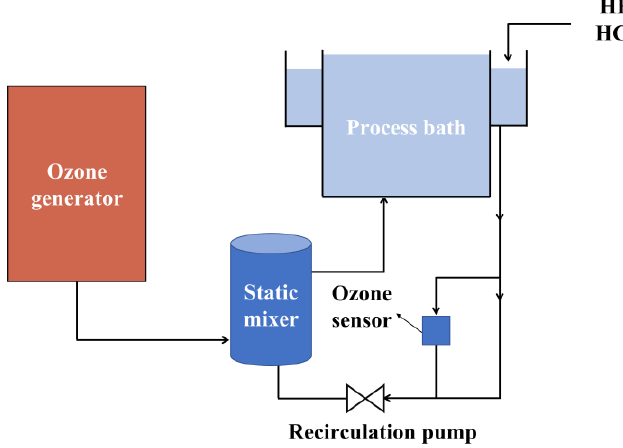
Figure 2. A schematic diagram of the ozone − based cleaning